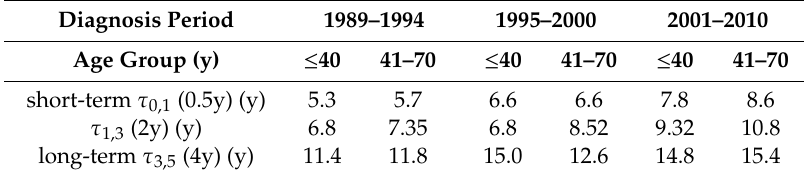
Table 2. Comparison between young and middle-aged patients with rectal cancer in ([4], Table 3). Diagnosis